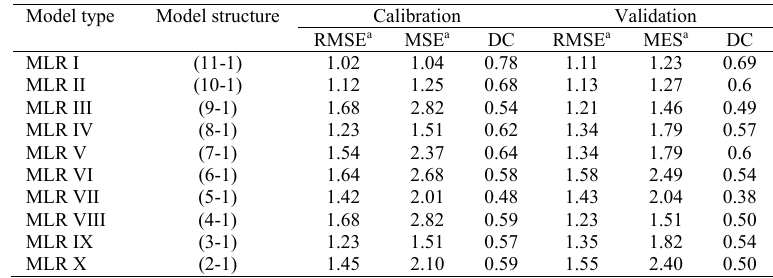
Table 3: Performance evaluation of MLR model